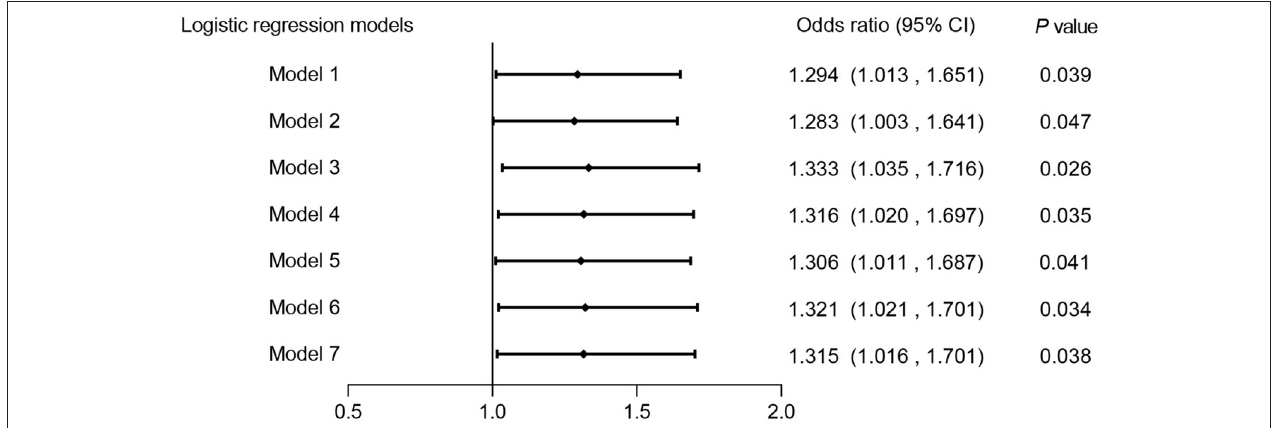
FIGURE 3 | Association between HP infection and CAS in different adjusted multivariate logistic regression models. Model 1: unadjusted. Model 2: adjusted for sex. Model 3: adjusted for age. Model 4: adjusted for age and sex. Model 5: adjusted for age, sex and metabolic syndrome. Model 6: adjusted for age, sex, metabolic syndrome and excessive salt intake. Model 7: adjusted for age, sex, metabolic syndrome, excessive salt intake and smoking. CAS, carotid atherosclerosis; HP, Helicobacter pylori